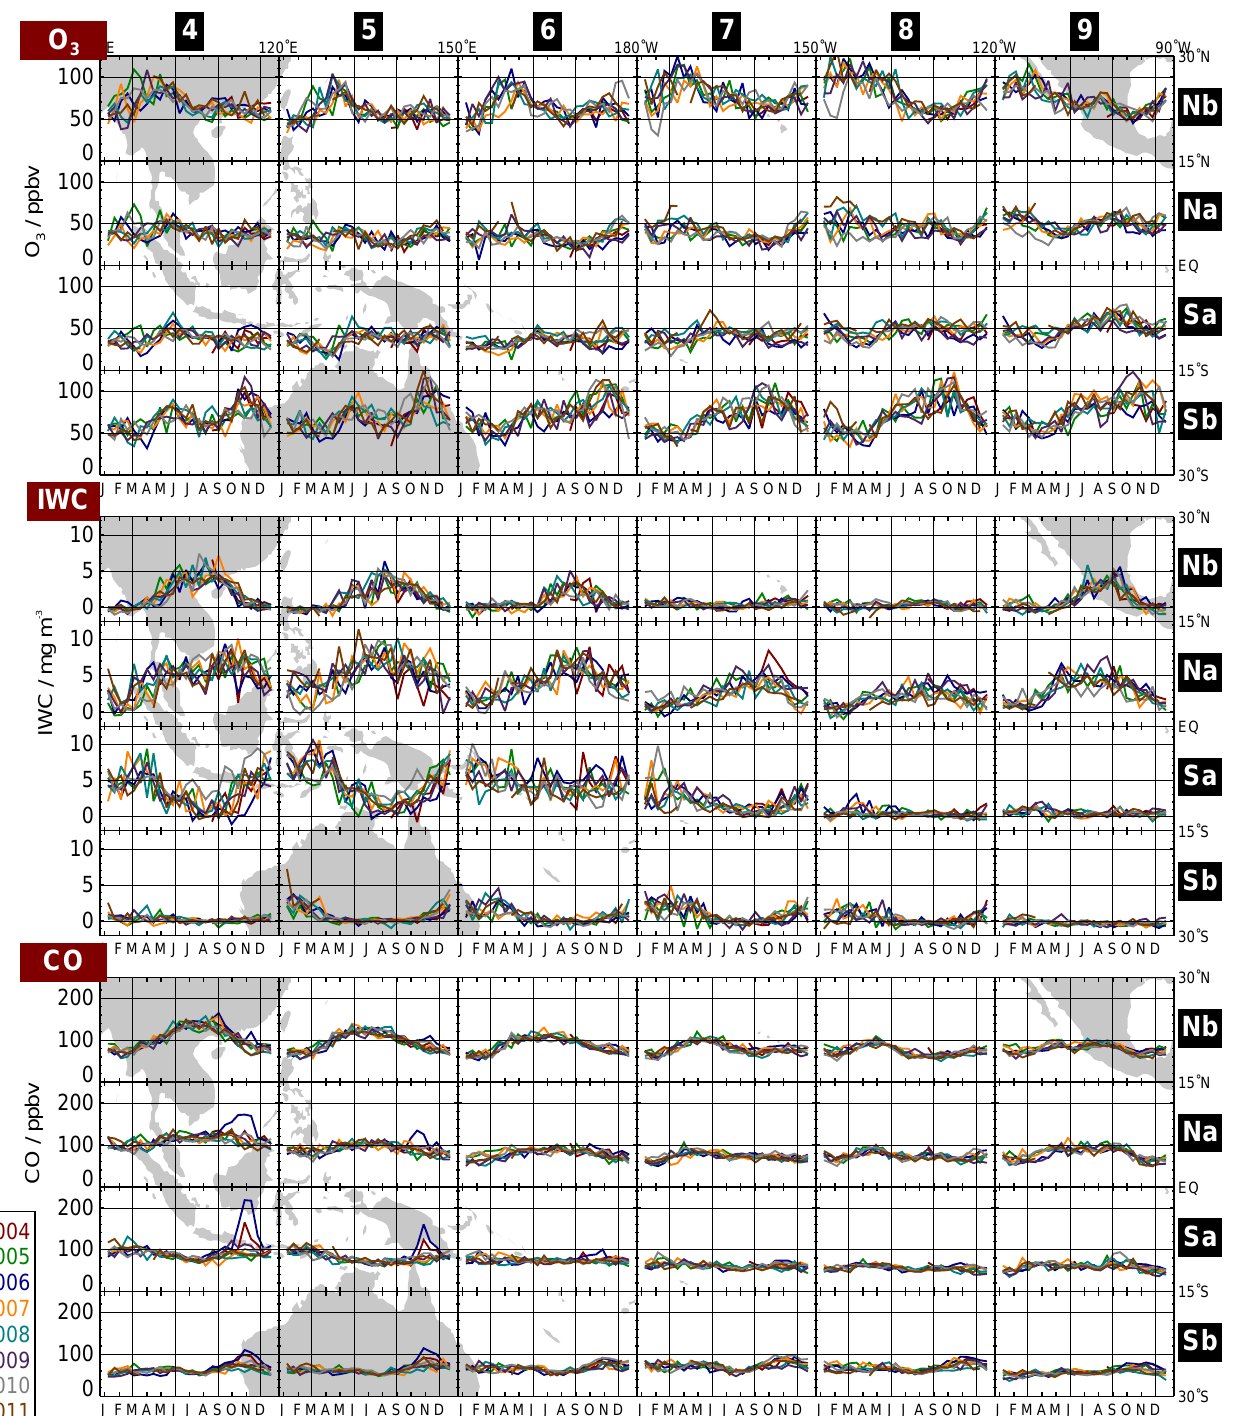
Fig. 2. As for Fig. 1 but for 90 ◦ E to 90 ◦